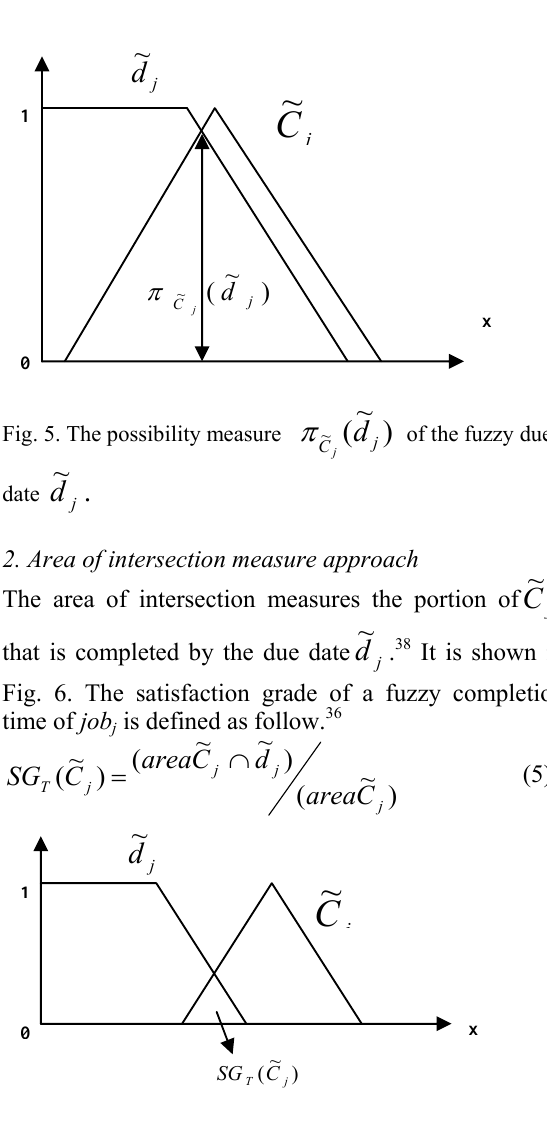
Fig. 6. Satisfaction grade of completion time using area of